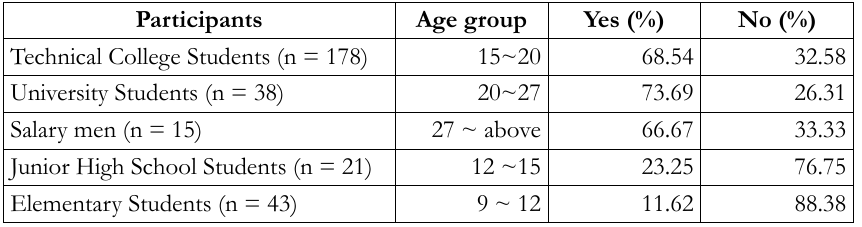
Table 3. Participants knowledge on